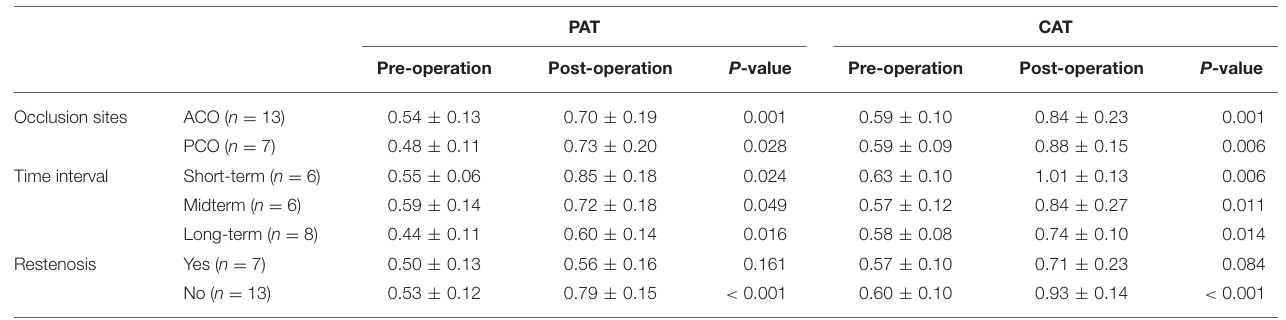
TABLE 3 | Stratified analysis of pre- and postoperative comparison of rCBF in the regions of PAT and CAT.